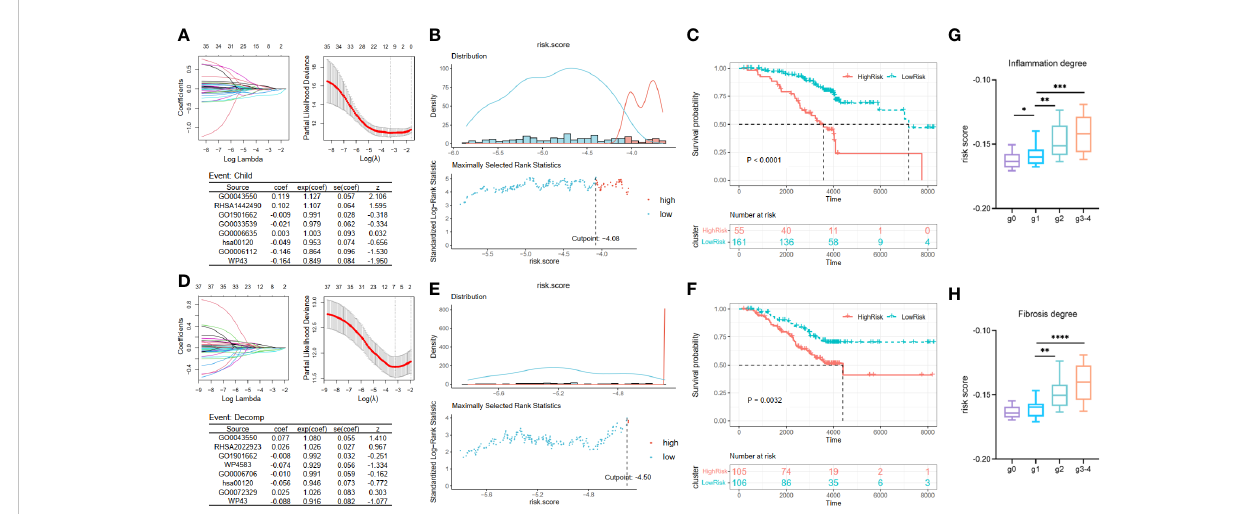
FIGURE 3 Construction and validation of liver function deterioration progression risk-related models. For the two events, (A, D) LASSO regression models were visualized. coef, regression coef fi cient; exp(coef), exponent coef fi cient (hazard ratio); se(coef), standard error of the coef fi cient; z, Wald statistic. (B, E) According to the cut point derived from maximally selected rank statistics, the patients were separated into two risk subgroups. (C, F) Kaplan – Meier plots of survival curve between high-risk and low-risk groups in two models. (G, H) Box plot showing a difference in Child – Pugh class progression related-risk score among the fi ve grades in two evaluation approaches. LASSO, least absolute shrinkage and selection operator. ****means p < 0.0001,*** means p < 0.001, ** means p < 0.01, and * means p <